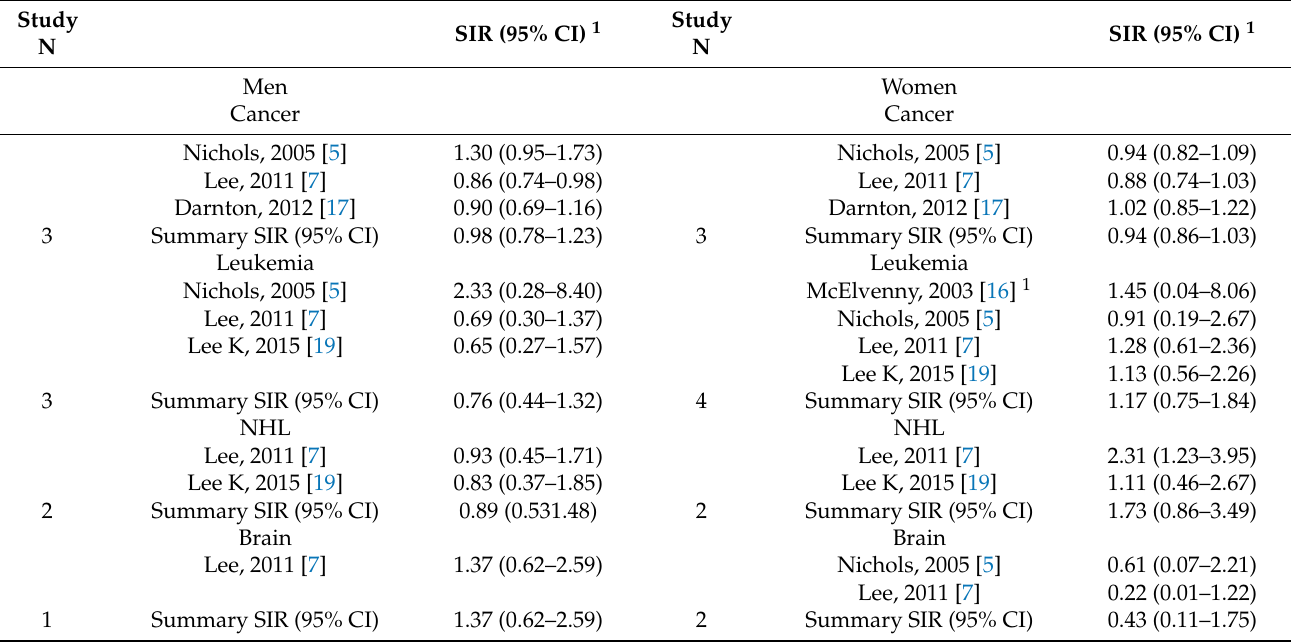
Table 3. Sex-specific meta-analysis for the standardized incidence ratios (SIRs) of cancer, leukemia, NHL, and brain tumor in semiconductor workers compared to the general